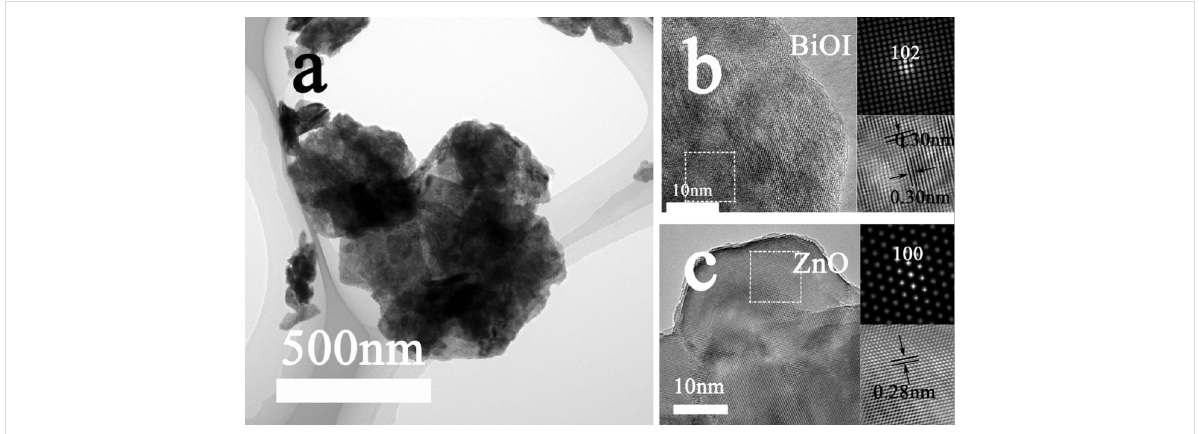
Figure 3: (a) TEM image of sample B-3 and high-resolution images further confirm that a heterostructured ZnO (b) and BiOI (c) nanocomposite is ob- tained.